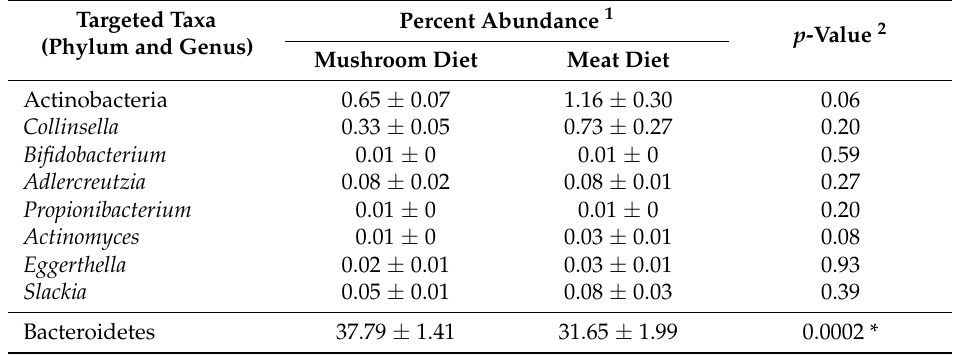
Table 9. Percent abundance across 5 days of fecal collection for identified abundant bacterial